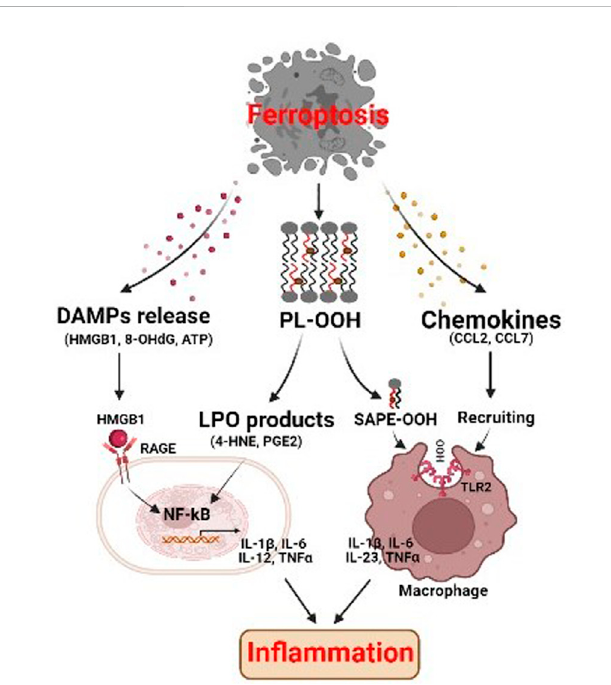
FIGURE 3 Ferroptosis affects in fl ammation through immunogenicity. The ferroptoticcellsreleasedamage-associatedmolecularpatterns(DAMPs) and lipid peroxidation products, which may promote in fl ammatory response through activating NF-kB pathway. SAPE-OOH on ferroptotic cell surface, the oxidized phospholipid, acts as an eat-me signal and navigates phagocytosis by targeting TLR2 on macrophages. Ferroptotic cells can also secrete chemokines which induce the recruitment of macrophages, and cause in fl ammation. HMGB1 high- mobility group protein B1, RAGE receptor for advanced glycation end- products, NF-kB nuclear factor kappa B, PL-OOH phospholipid-OOH, 4-HNE 4-hydroxynonenal, PGE2 prostaglandin E2, SAPE-OOH 1- steaoryl-2-15-HpETE-sn-glycero-3phosphatidylethanolamine, TLR2 toll like receptor